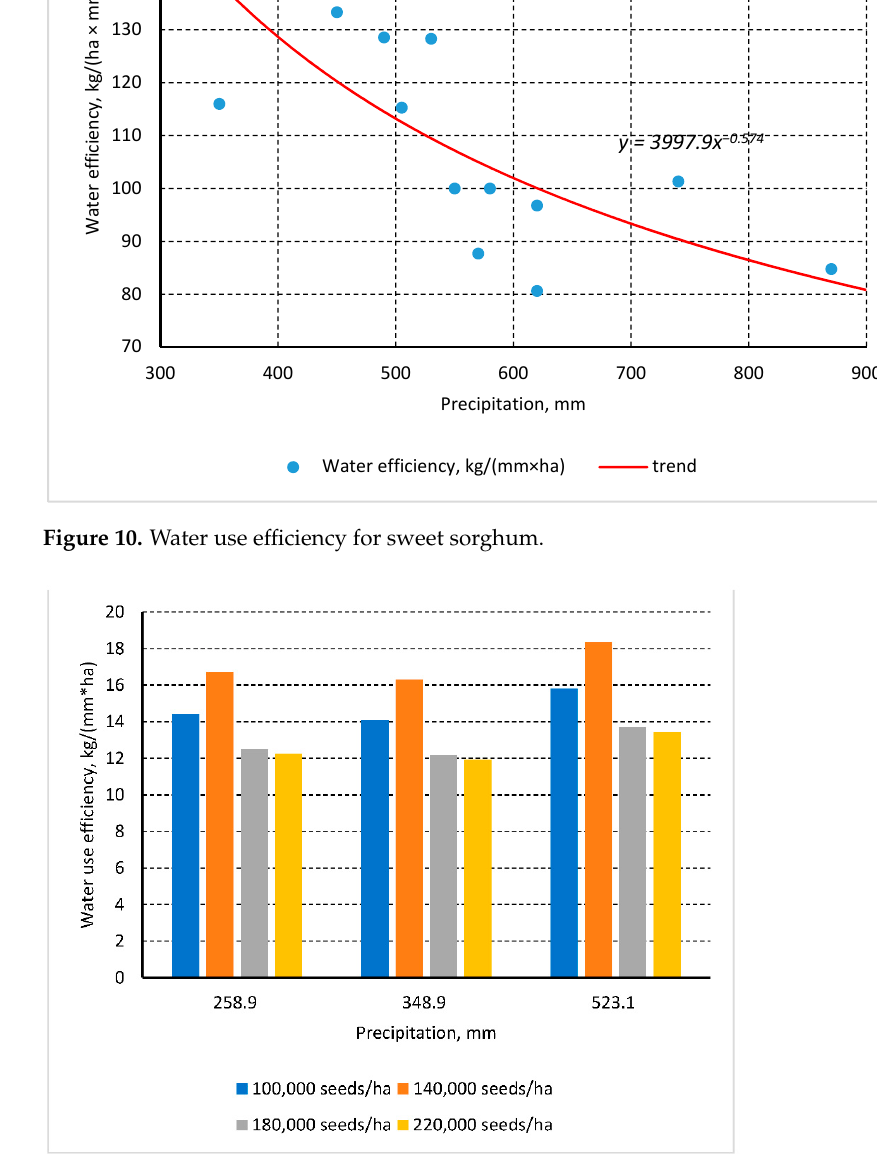
Figure 11. Water use efficiency for grain sorghum.